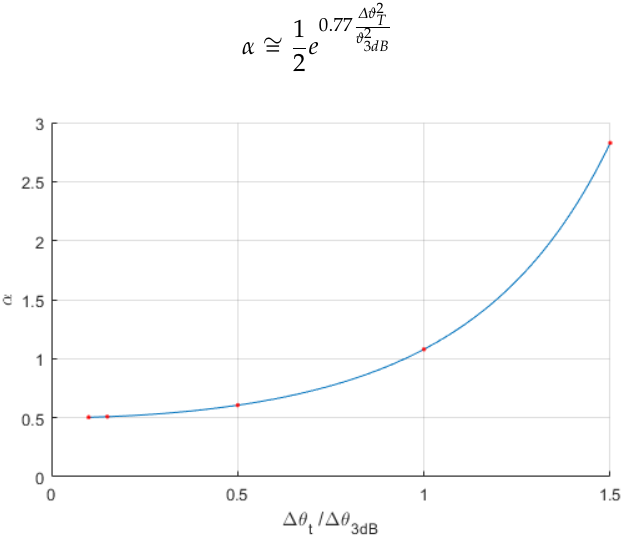
Figure 6. Corrective factor to be applied to the approximated